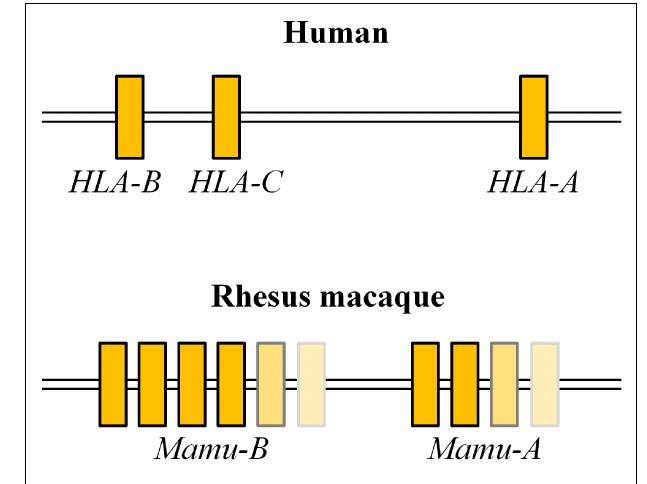
FIGURE 1 | Comparison of genome structures of MHC-I sub-regions in humans and rhesus macaques. Humans have a single polymorphic HLA-A, HLA-B, and HLA-C locus per chromosome, while rhesus macaques have variable numbers of Mamu-A and Mamu-B loci per chromosome.